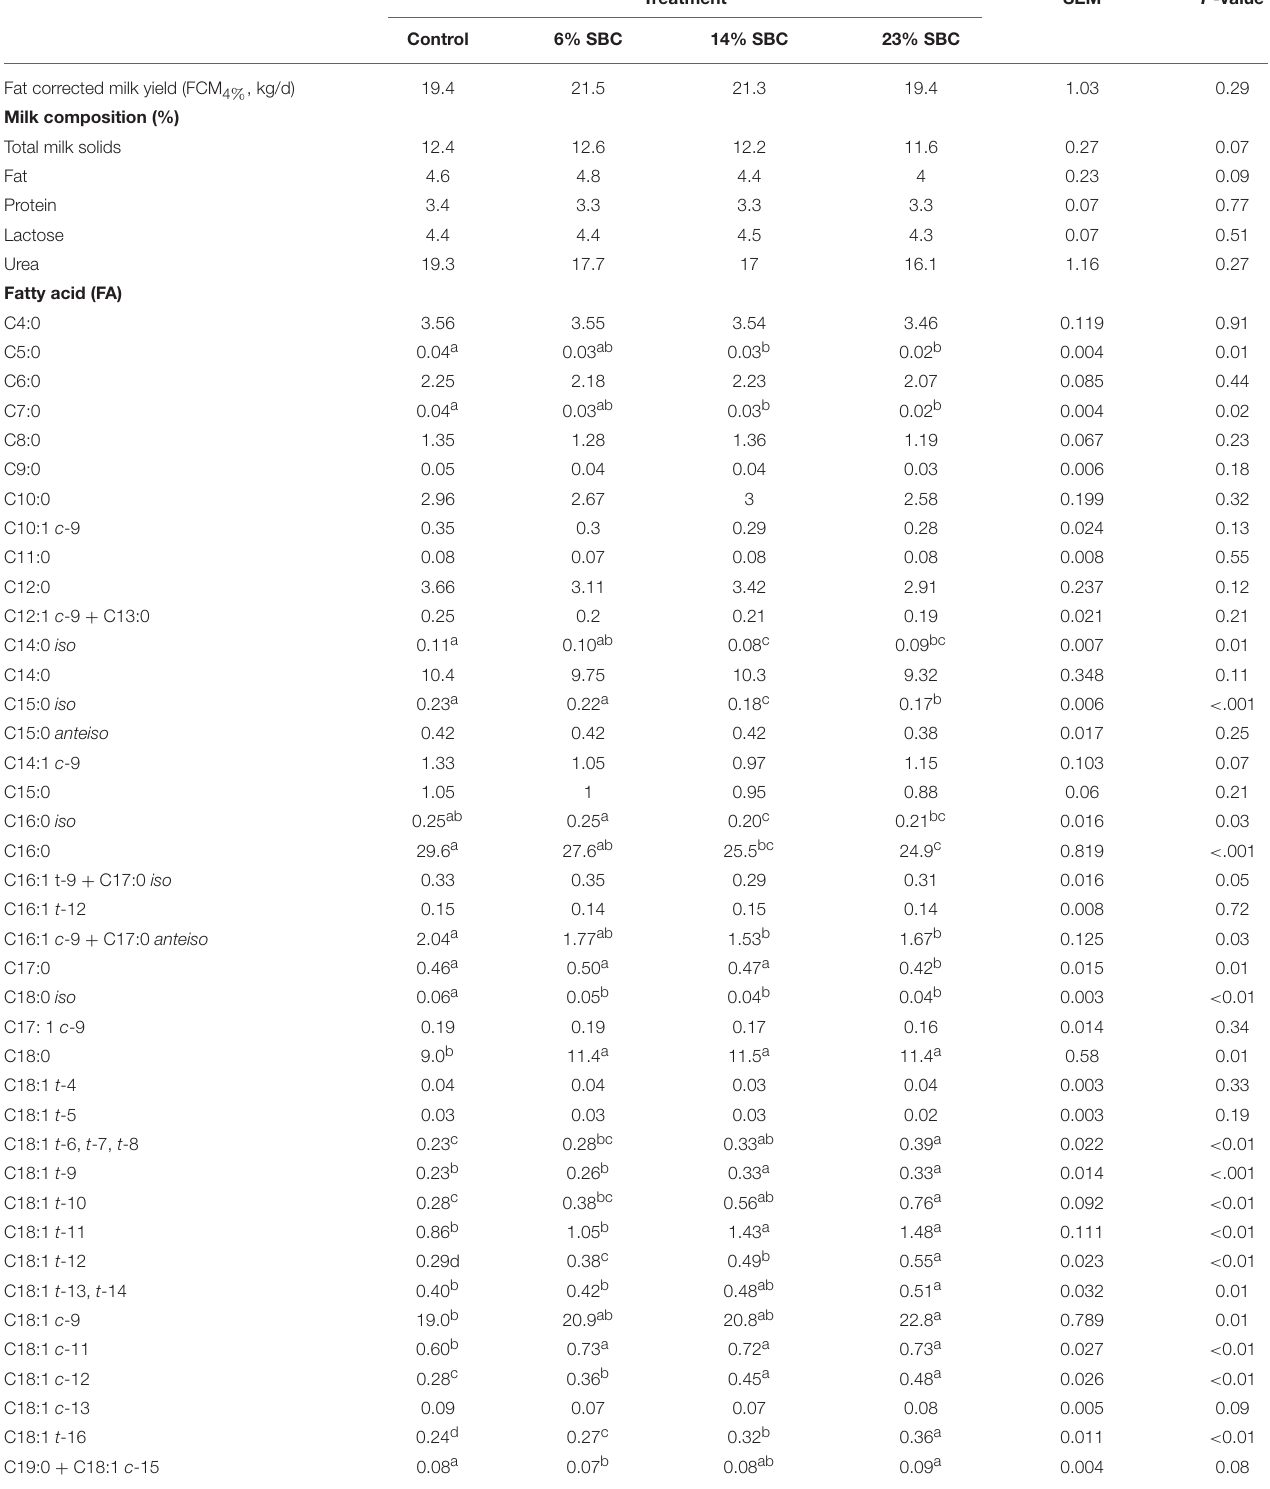
TABLE 4 | Effect of replacing soybean meal (SBM) with soybean cake (SBC) on milk production, milk composition, and milk fatty acids of dairy cows. Treatment SEM P -value Control 6%